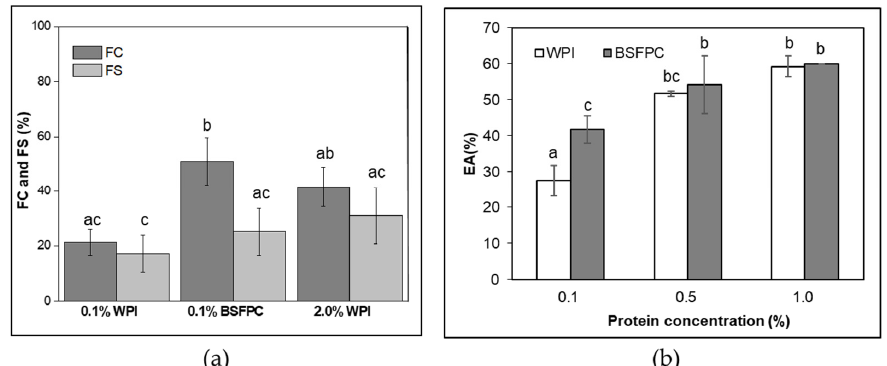
Figure 4. ( a ) FC (foaming capacity) and FS (foam stability) among different concentration of WPI (whey protein isolate) and BSFPC (black soldier fly protein concentrate); ( b ) EA (emulsifying activity) compared WPI with BSFPC. Different lowercase letters indicate significant differences at the p < 0.05 level.